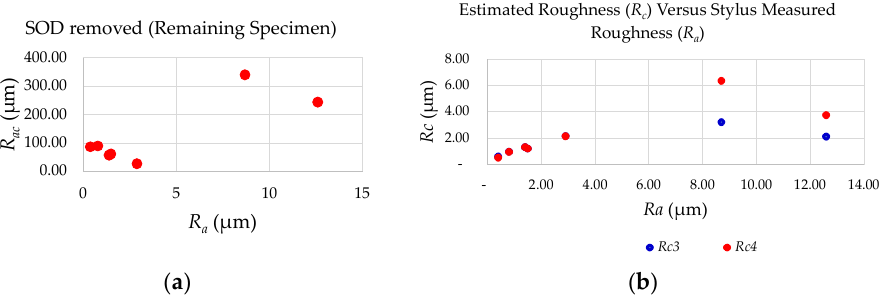
Figure 9. Response of estimated roughness for remaining specimens: ( a ) SOD removed from com- puted Z m ; ( b ) estimated capacitance roughness (R c ).